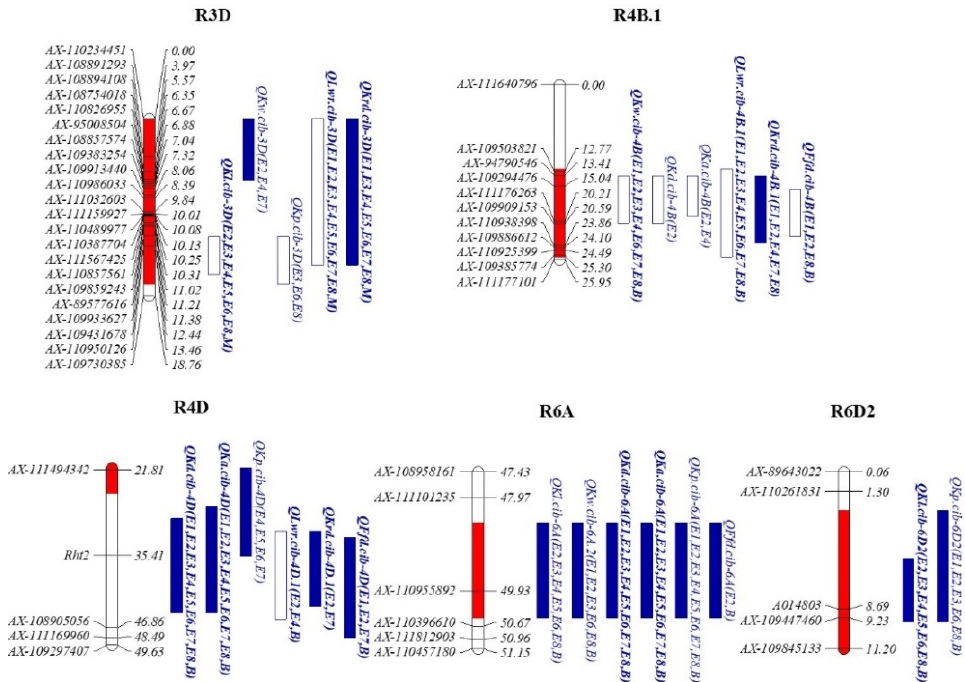
Figure 3. Five regions harboring stable major QTLs in this study. The solid rectangle indicates the ZKM138-derived alleles increasing the corresponding traits; the blank rectangle indicates the KCM2-derived alleles increasing the corresponding traits. The QTL in bold indicates the major QTL. The parentheticals following the QTL names indicate the datasets in which they were detected. The red segments highlighted on the chromosomes indicate the putative CI range of this